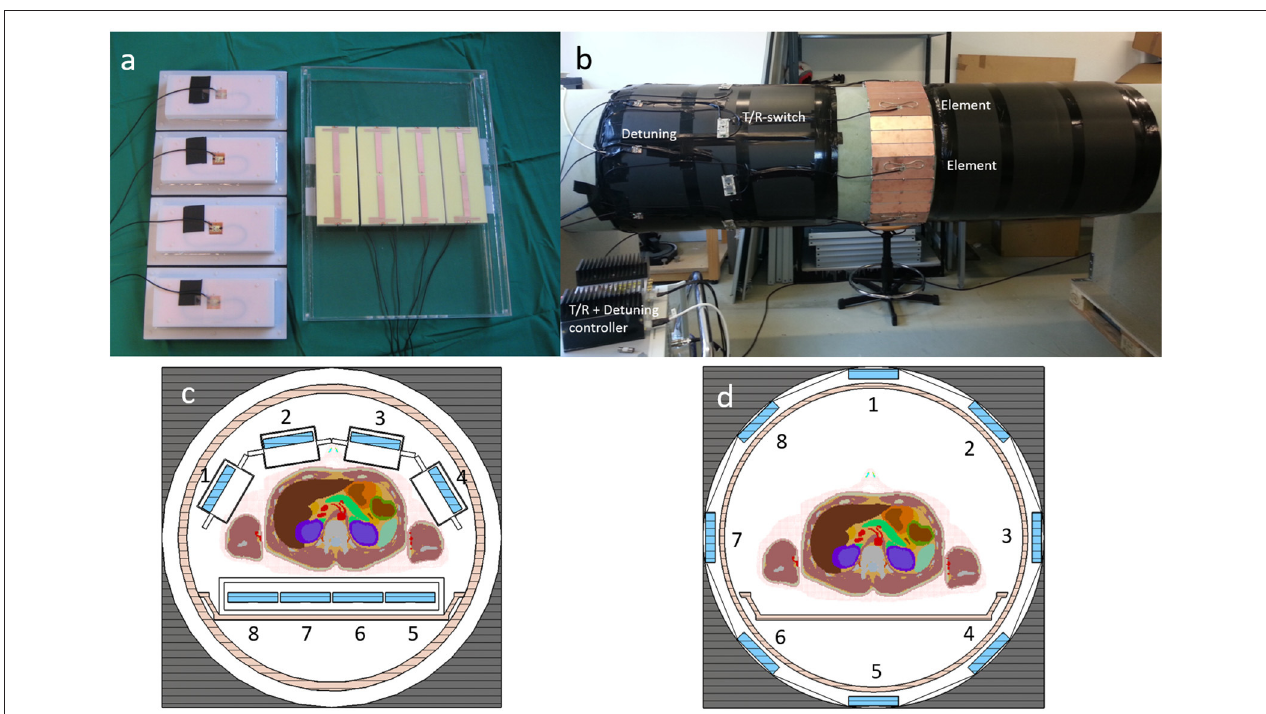
FIGURE 1 | The two coil setups under comparison. (a) The local coil, consisting of flexible anterior half and rigid posterior half, (b) the 8-channel integrated body array including T/R switches, detuning boards, and PIN diode controller. The black material is sound-dampening foam. Panels (c,d) show CAD models of the two coils. The positions of the numbered elements are highlighted in